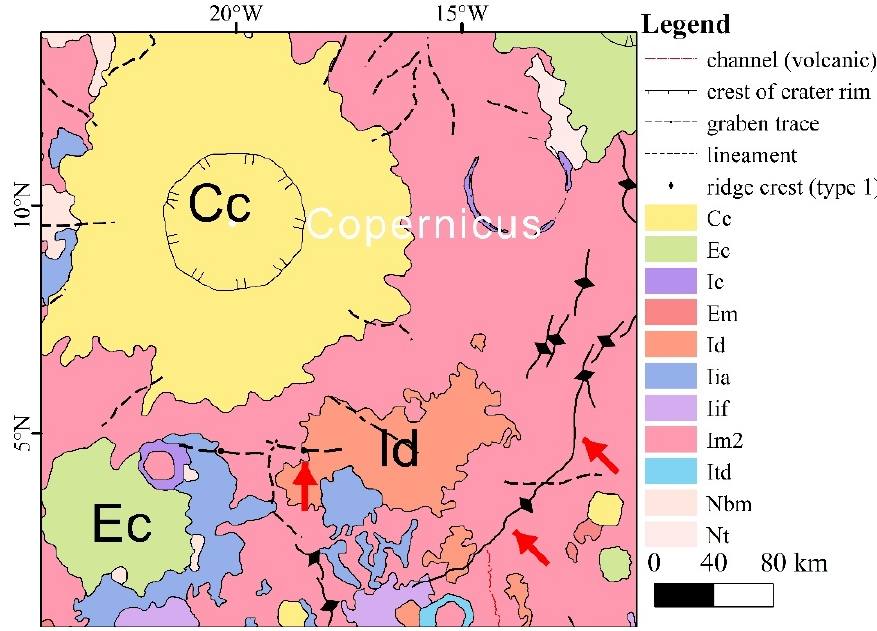
Figure 5. Geology map of the Copernicus area showing the linear rilles and mare ridges.